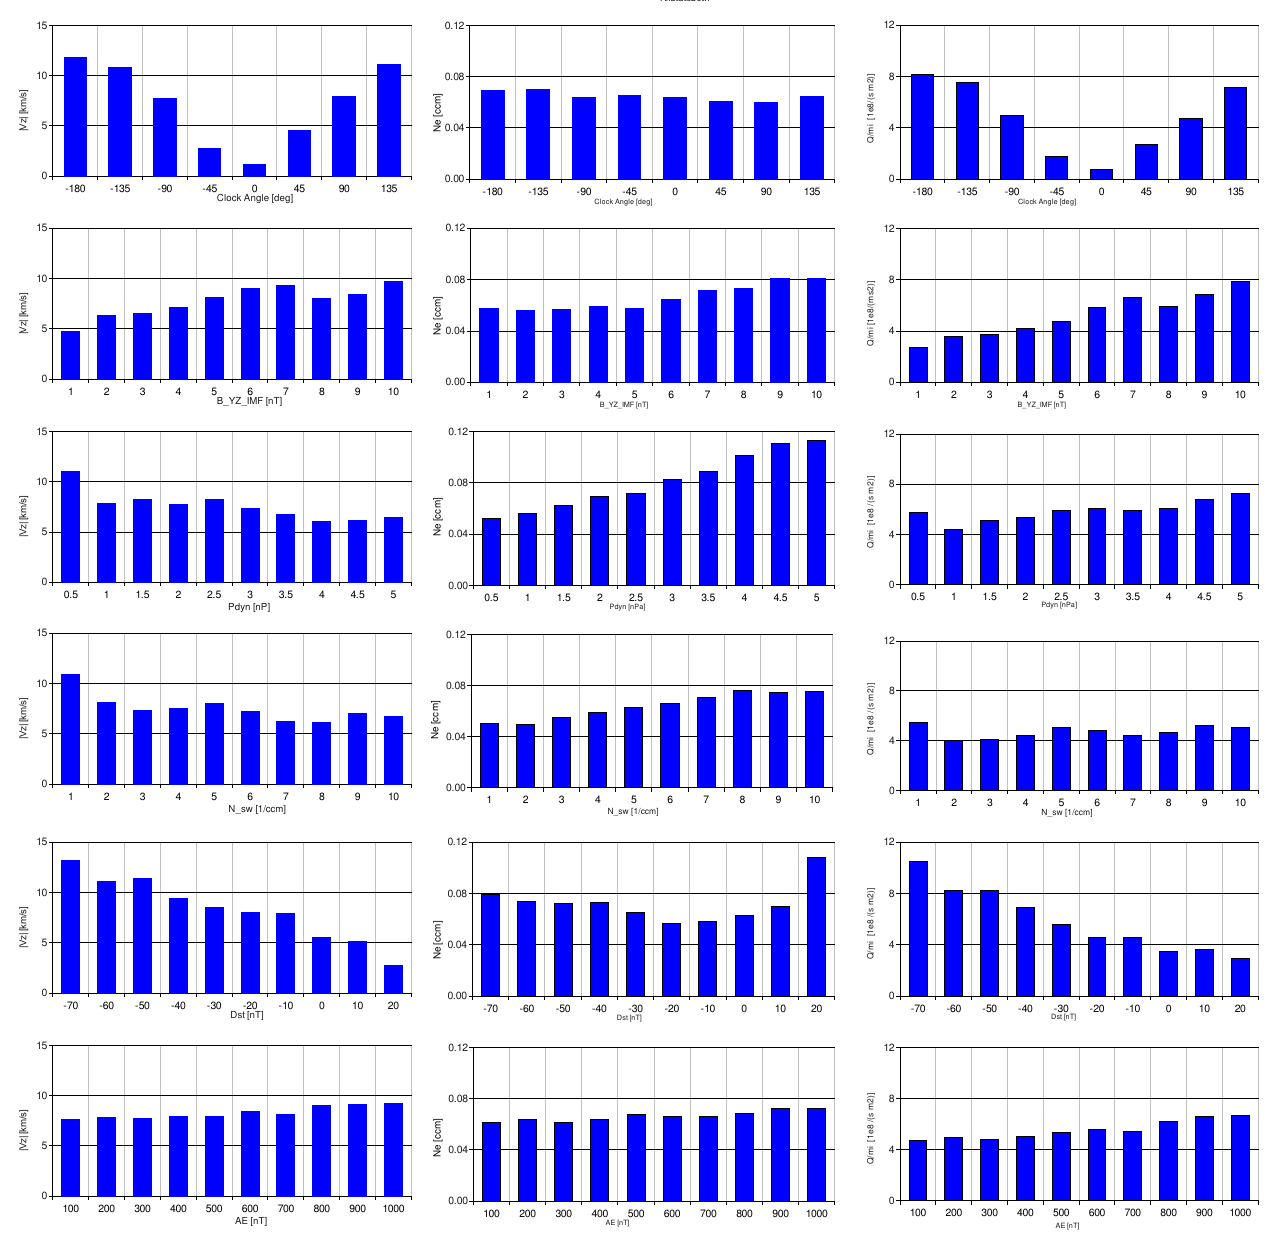
Fig. 2. Correlation between convection, density and number flux versus solar wind and disturbance parameters. The left panels show the average convection velocities, the middle panels show average densities, and the right panels show the calculated number flux for each subset of a particular driver parameter. From top to bottom, we show the correlation of these three parameters versus (a) IMF clock angle, (b) IMF magnitude, (c) solar wind dynamic pressure, (d) solar wind density, (e) the D st index, (f) the AE index. For the clock angle correlation, the numbers along the horizontal axis show the center of the clock angle sector, i.e., 0 means the average obtained from the 45 ◦ wide clock angle sector ranging from from − 22.5 to +22.5 degrees. For the other parameters, the numbers indicate the upper limit of the